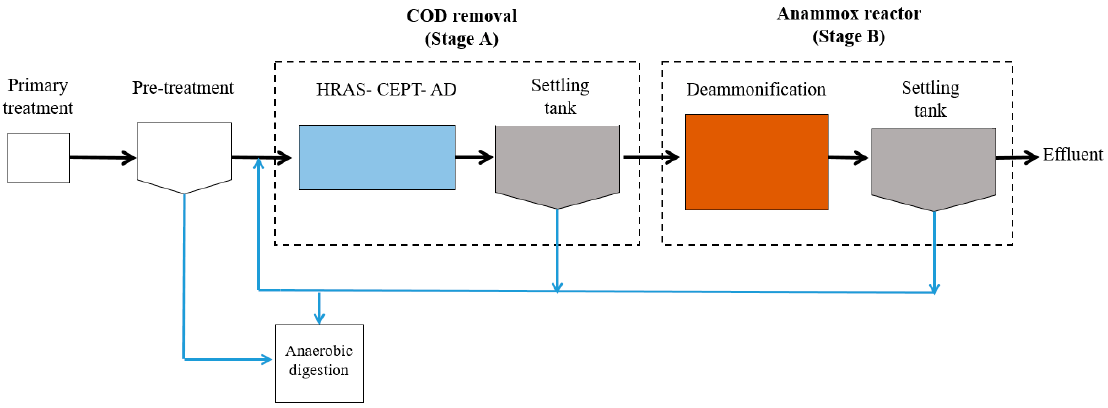
Figure 5. A two ‐ stage configuration of the deammonification process based on [12]. Figure 5. A two-stage configuration of the deammonification process based on